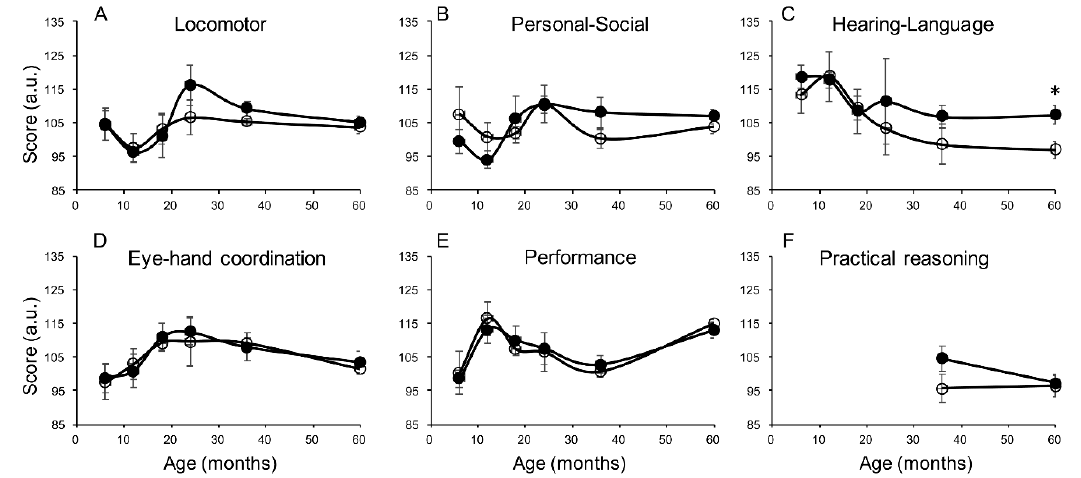
Figure 1. Cognitive development measured in the six cognitive domains ( A-F ) in exclusively breastfed (closed circles) and nonexclusively breastfed (open circles) girls at different ages (6, 12, 18, 24, 36, 60 months). N = 9, 10, 14, 10, 13, 25 at progressive ages. Practical reasoning skills are measured from the age of 36 months. Data are represented as mean ± sem. * p ≤ 0.05.